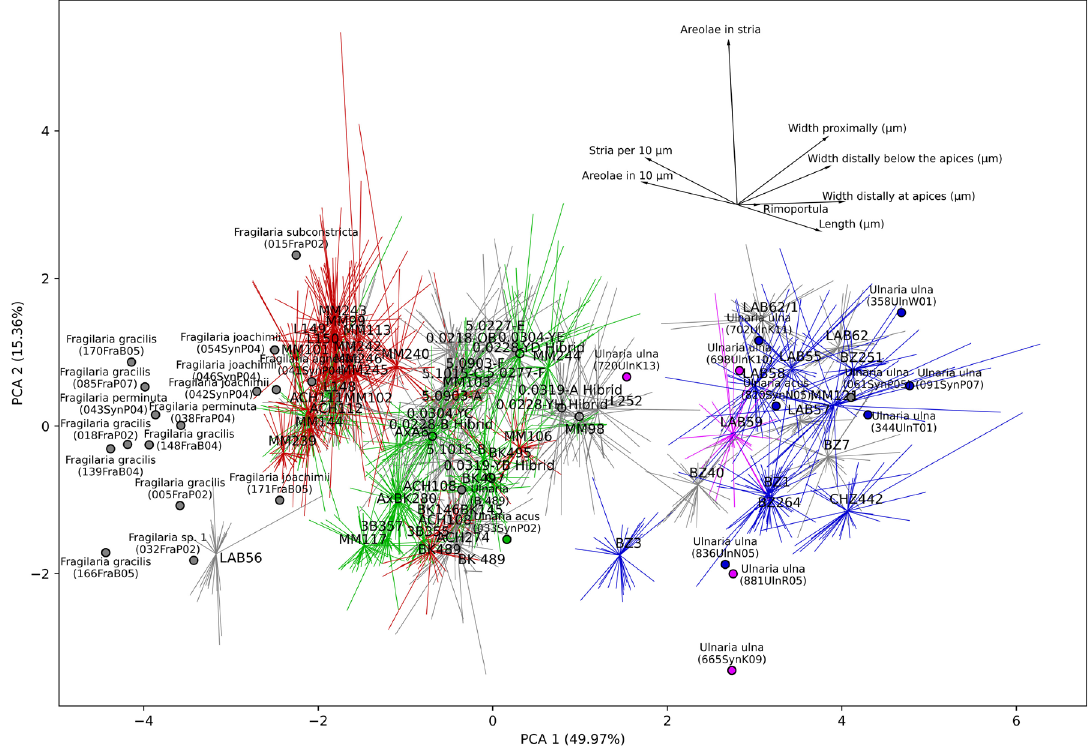
Figure 8. Principal component analysis (PCA) of strain morphometry. Each “snowflake” corresponds to a single strain, with the central point being a vector of strain averages for each trait and ray endpoints corresponding to individual cells. The strains are designated according to the name of the strains in Supplementary Table S3. The strains are painted and flashed to the groups in which they entered the phylogenetic reconstruction of the rbc L genetic marker (Figure 1).